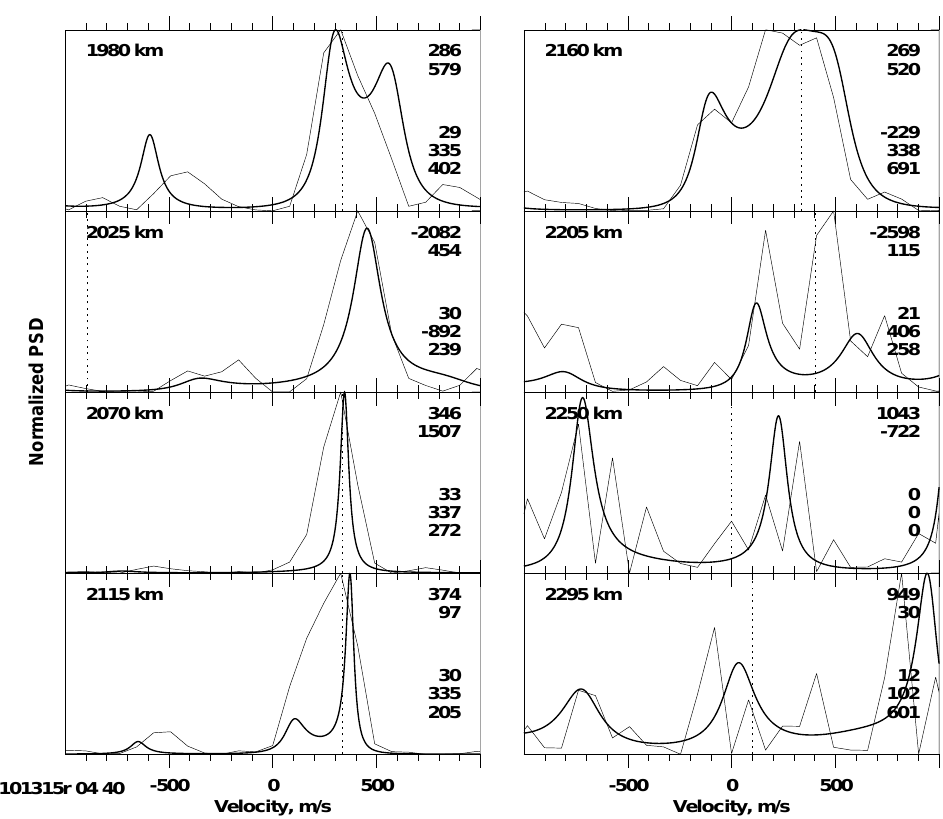
Fig. 5. Eight examples of DFT Doppler spectra (light curves) and Burg spectra (bold curves) calculated using ACFs recorded on beam 4 between ranges 1980km and 2295km at 13:15UT on 10 December 1999. In each panel, the Doppler velocities of the two main peaks are given at top right, and the FITACF power, line-of-sight velocity, and spectral width are given at bottom right. The spectra at all ranges except 2025, 2070, and 2115km are double-peaked spectra using our selection